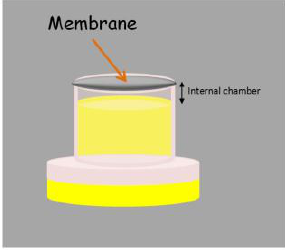
Figure 5. Stir membrane extraction device working in the liquid phase microextraction context.